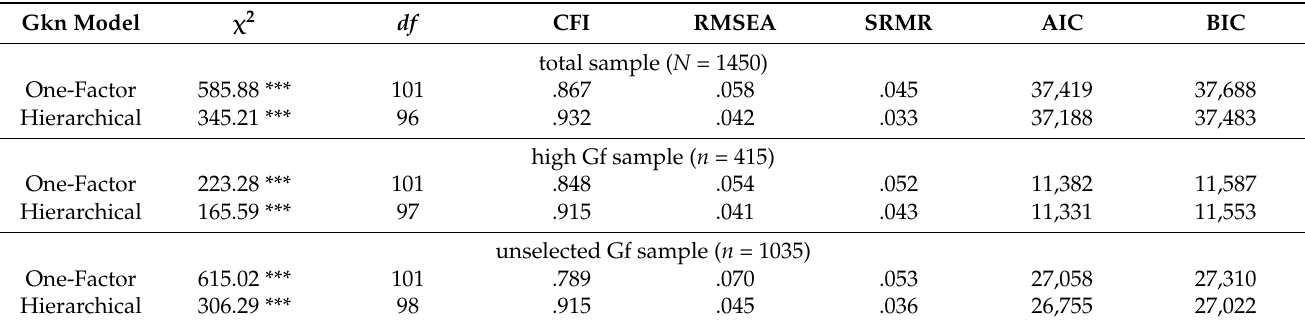
Table 7. CFA for General Gkn Models (All Samples).